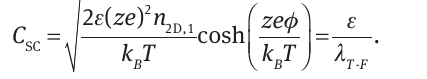
While such a form seems similar to that of Eq.